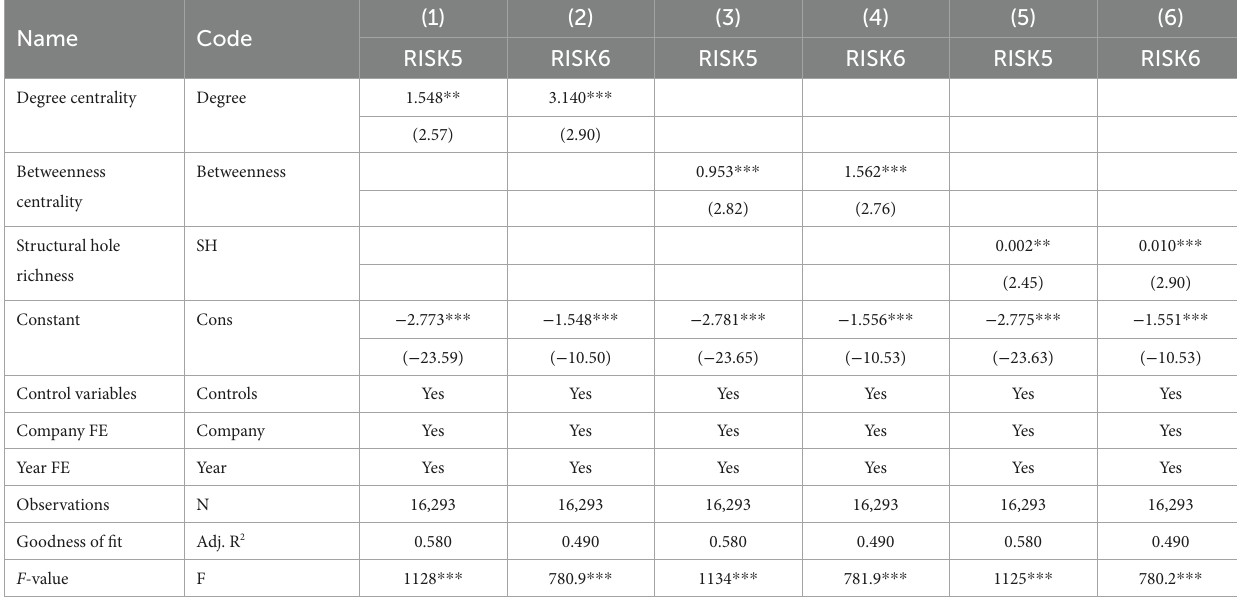
TABLE 7 Indicator sensitivity test: volatility of stock